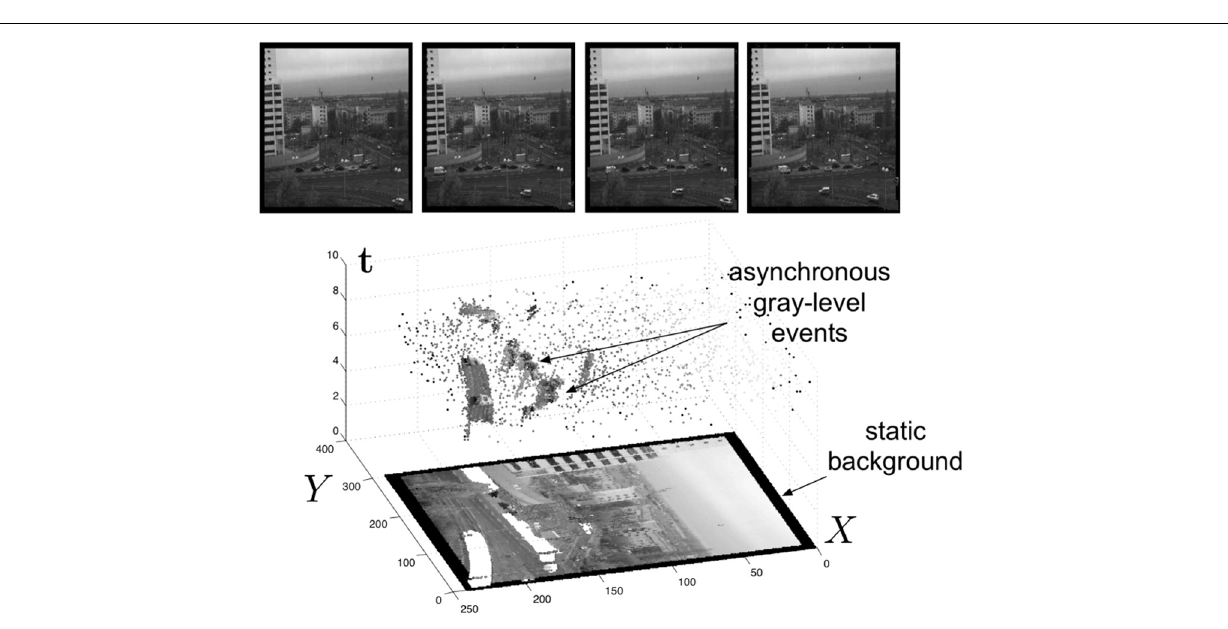
change. Frames are absent from this acquisition process. Samples of generated images from the presented spatio-temporal space are shown in the upper part of the